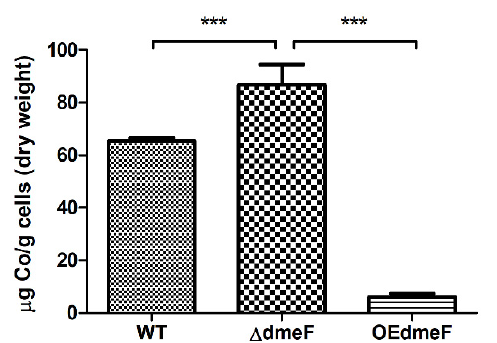
Figure 6. Cellular Co content in the WT, ∆ dmeF , and OE dmeF strains. These strains were grown in the presence of 0.1 mM CoSO 4 for 6 h. Cellular Co content was analyzed by inductively coupled plasma-mass spectrometry. Results represent the means and SD from five biological replicates. The data were analyzed using one-way analysis of variance along with Bonferroni’s post-test. ***, p < 0.001.